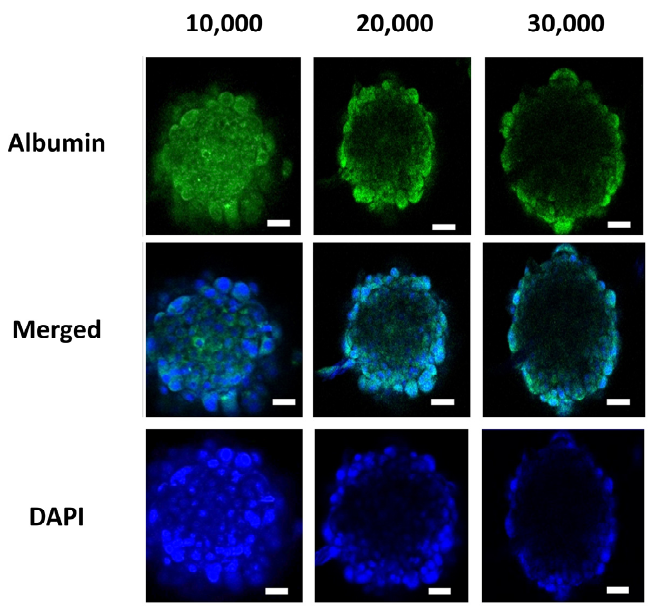
Figure 4. Representative images of the immunofluorescence staining of hepatocyte marker albumin (green) and DAPI (blue) at the end of Day 6. (Scale bar: 100 μ m).